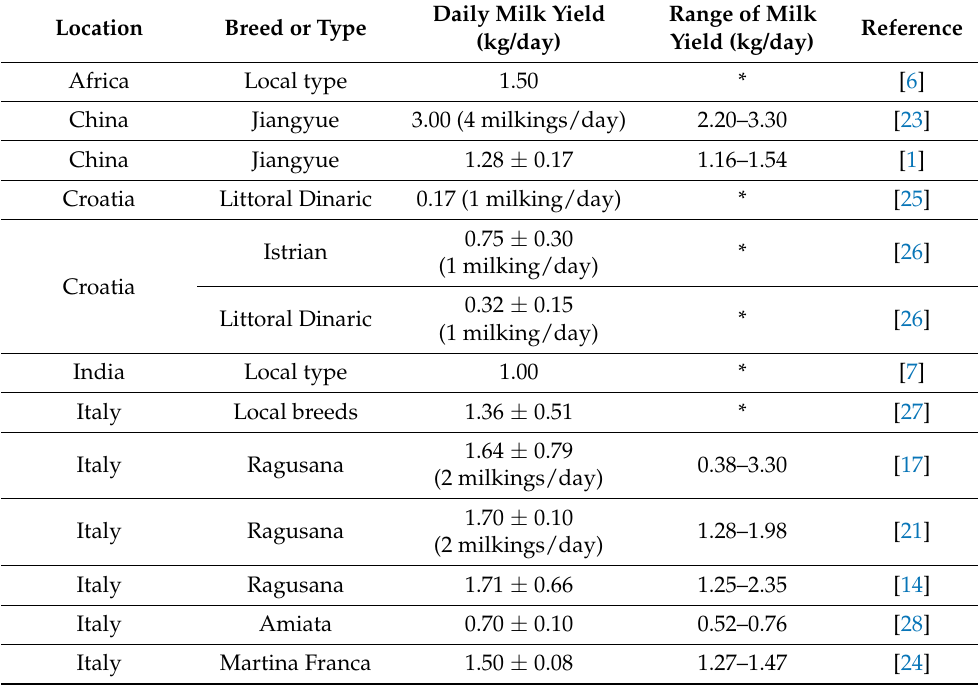
Table 1. Average daily milk yield of the donkey mare during the lactation